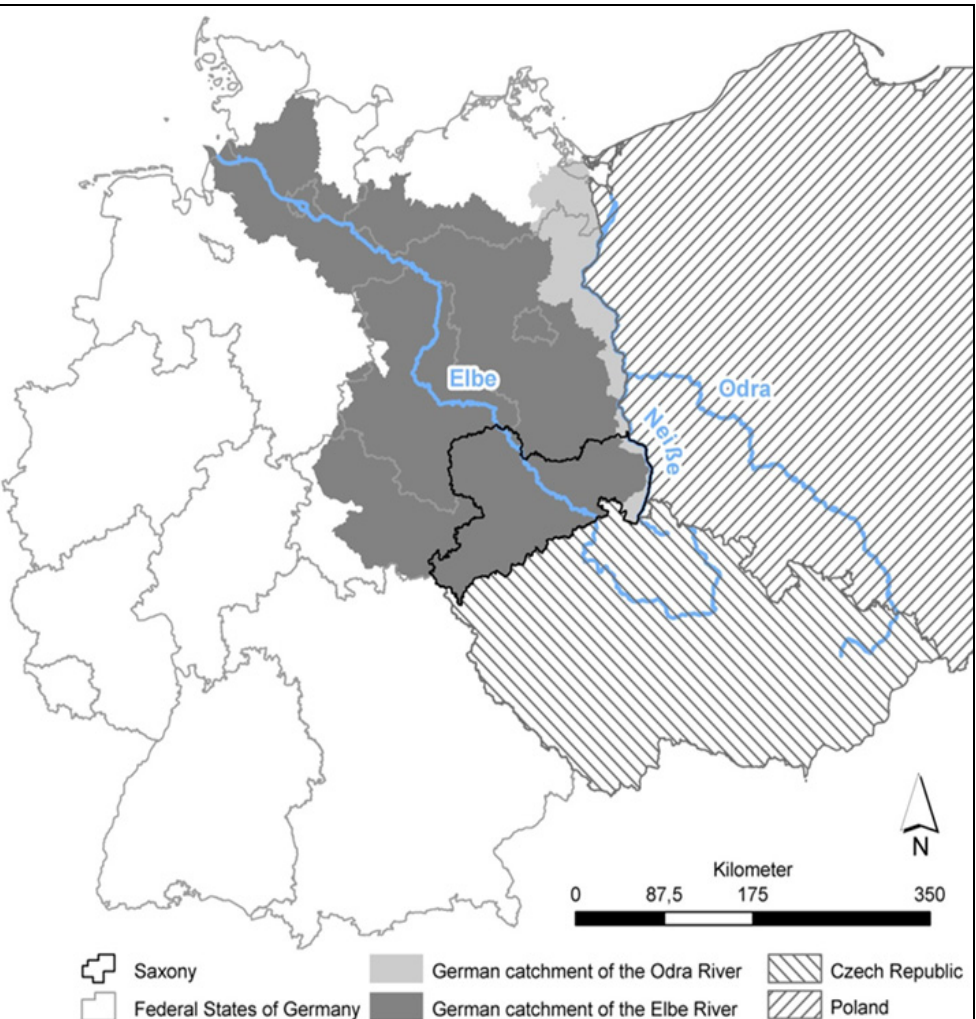
Figure 1. Map of Germany, Czech Republic and part of Poland with the location of Saxony in the tri-border region and the German parts of the rivers Elbe and Odra